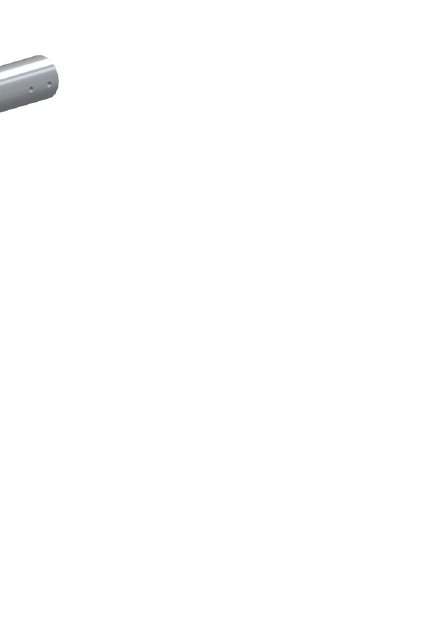
Fig 25. Addition of leadscrew_handle to the Lead Screw for Foot